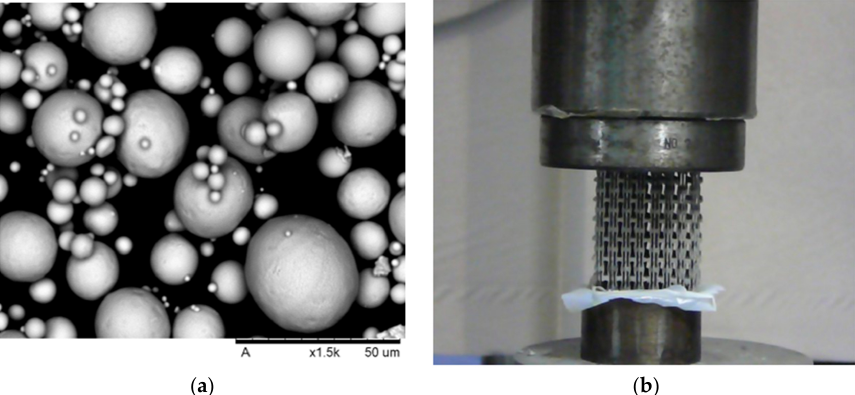
Figure 3. ( a ) SEM of the NiTi powder, and ( b ) the fabricated auxetic structure under compression